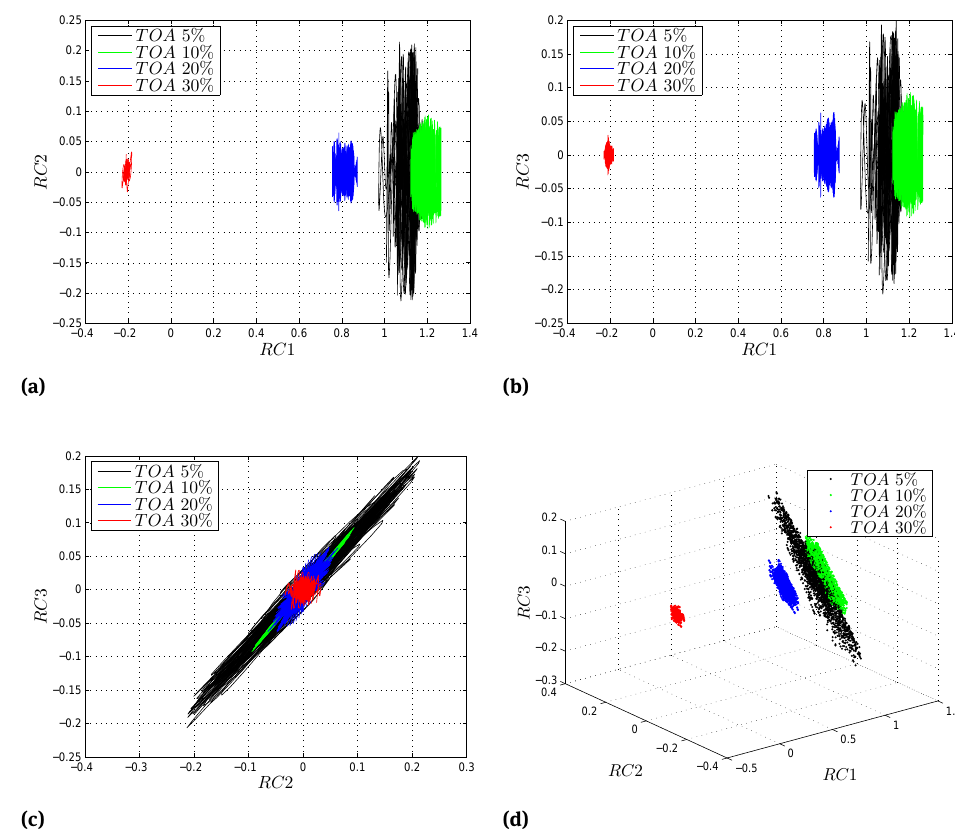
Figure 12: Phase portraits of the blower inlet signal on orthonormal basis created from the first three principal components